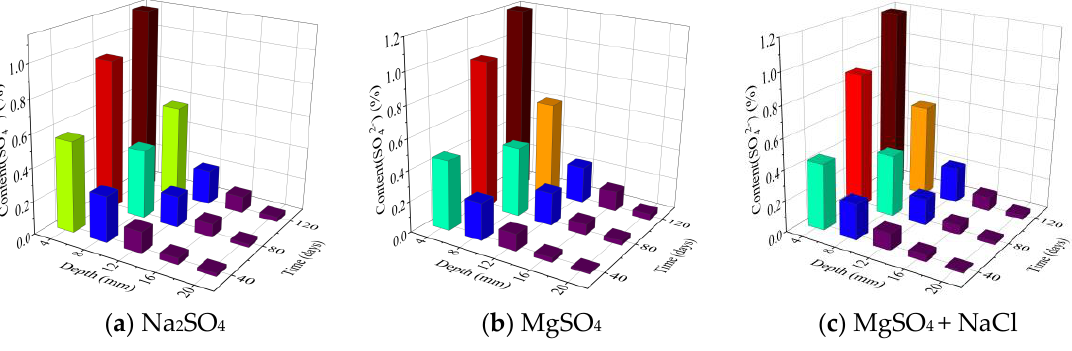
Figure 8. SO 4 2− Content in MK Concrete. Figure 8. SO 42 − Content in MK